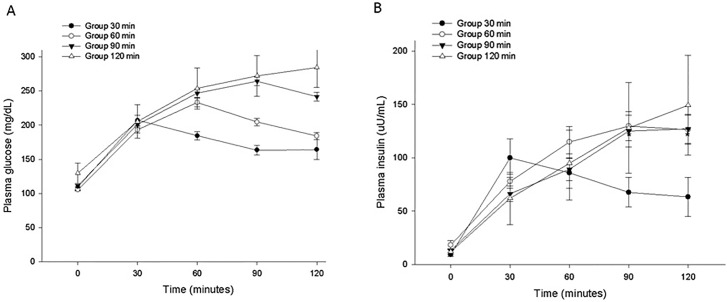
Mean ± standard error for plasma glucose (A) and insulin (B) concentration during the oral glucose tolerance test.